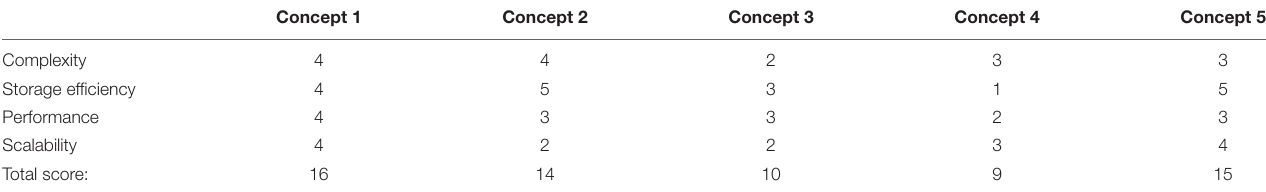
TABLE 5 | Evaluation of container handling concepts.